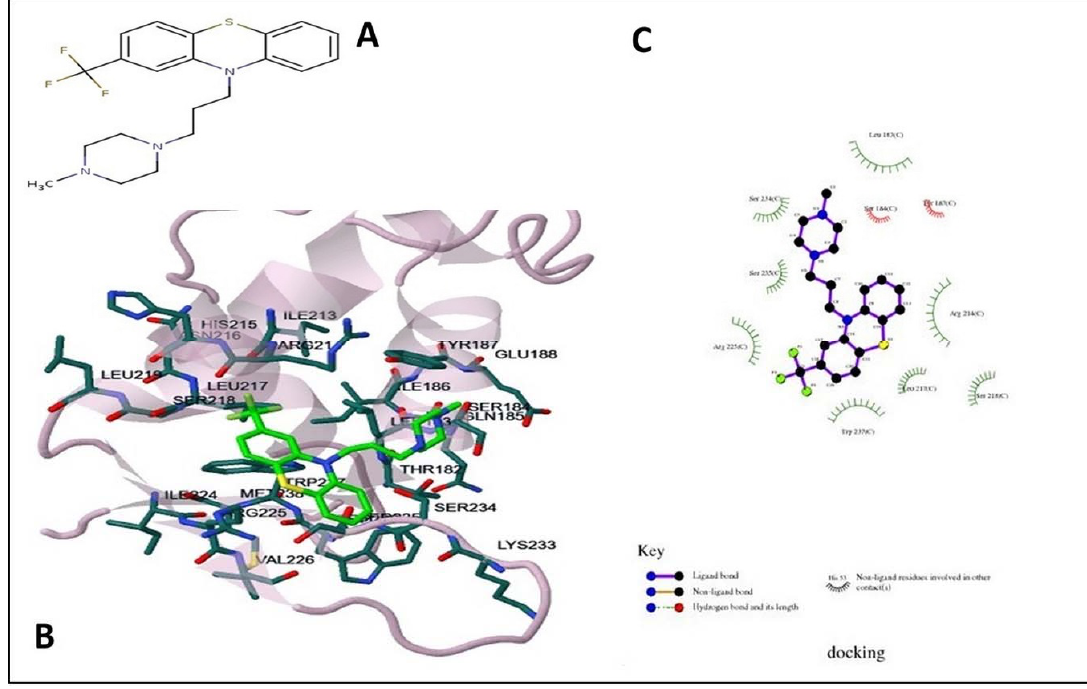
Figure 5. Molecular docking of trifluoperazine with FOXO1 protein. ( A ) Depicting the molecular structure of trifluoperazine; ( B ) Structure visualization of FOXO1 protein bound with ligand TFP. The binding site is shown and the interacting residues are labeled. ( C ) 2D plot of trifluoperazine of FOXO1 showing ligand–protein interaction profiled by AutoDock software of Docking Server. Leu183, Tyr187, Leu217, Arg225, Arg234, Ser184, Ser218, Ser234, Ser235 and Trp237 residues of FOXO1